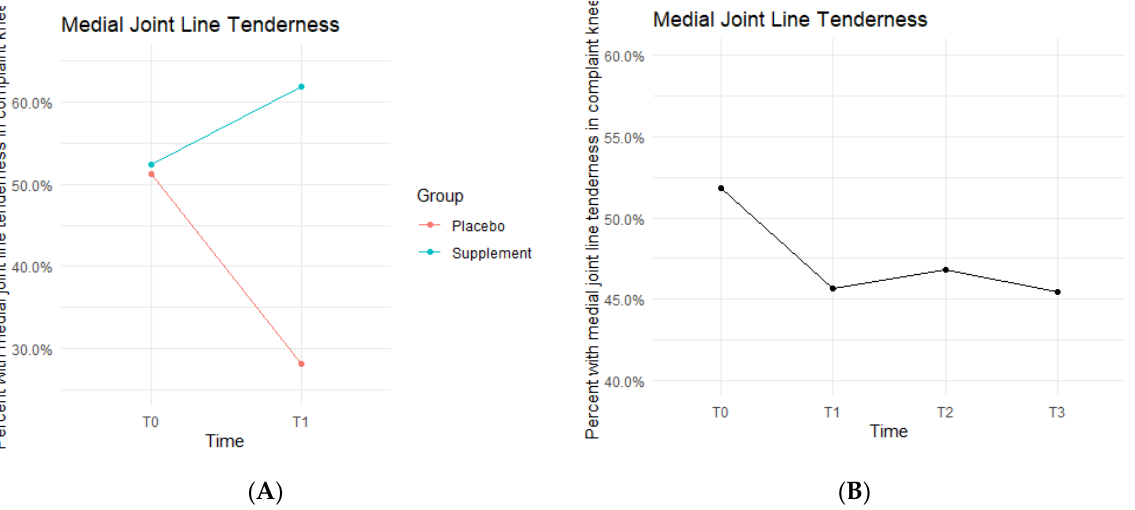
Figure 8. MJL Tenderness Changes Over Time. Average percentages of participants with MJL tenderness were graphed on a plot. ( A ) compares Supplement vs. Placebo from T0 to T1. ( B ) shows averages for the entire cohort as a whole at times T0, T1, T2, and T3. Only affected knees were included in the data.